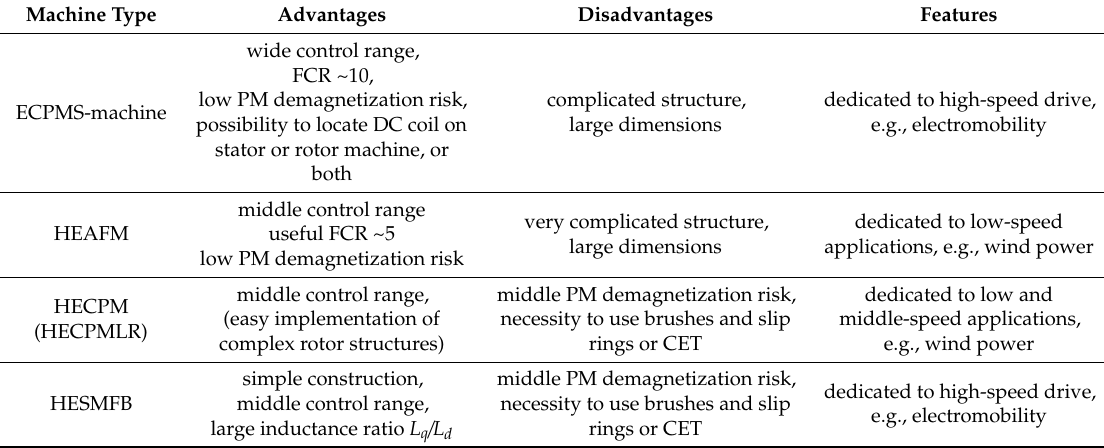
Table 3. Characteristic features of tested machines.